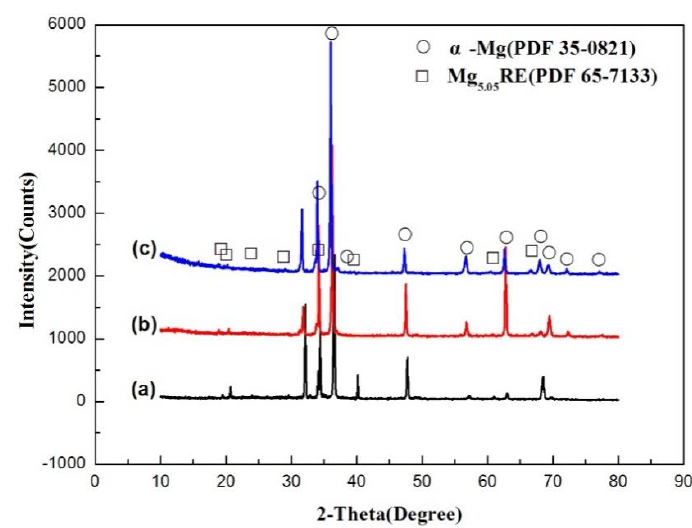
Figure 4. X-ray diffraction (XRD) spectra of the as-cast alloys: ( a ) Alloy A, ( b ) Alloy B, ( c ) Alloy C.